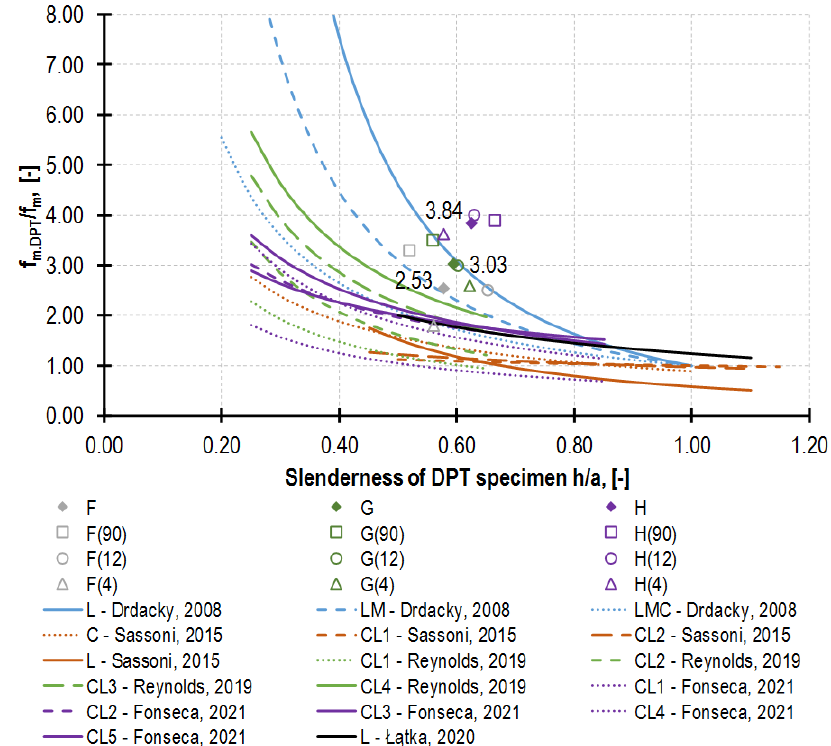
Figure 20. Relationship between specimen slenderness (specimen thickness, h /punch diameter, a )